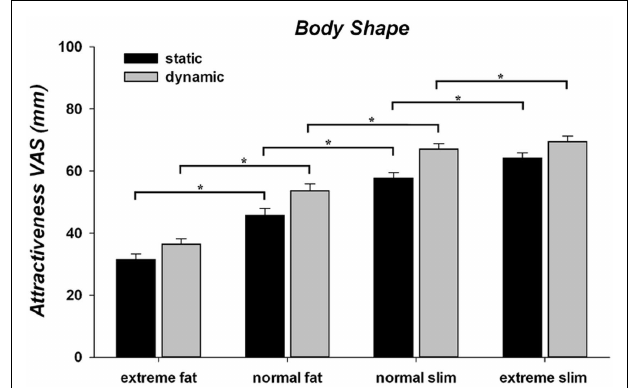
FIGURE 2 | Mean and standard error of mean for attractivenessVAS ratings of human models body shape as a function of implied motion (static/dynamic) along the four categories of body weight (extreme fat/normal fat/normal slim/extreme slim). * p < 0.05.